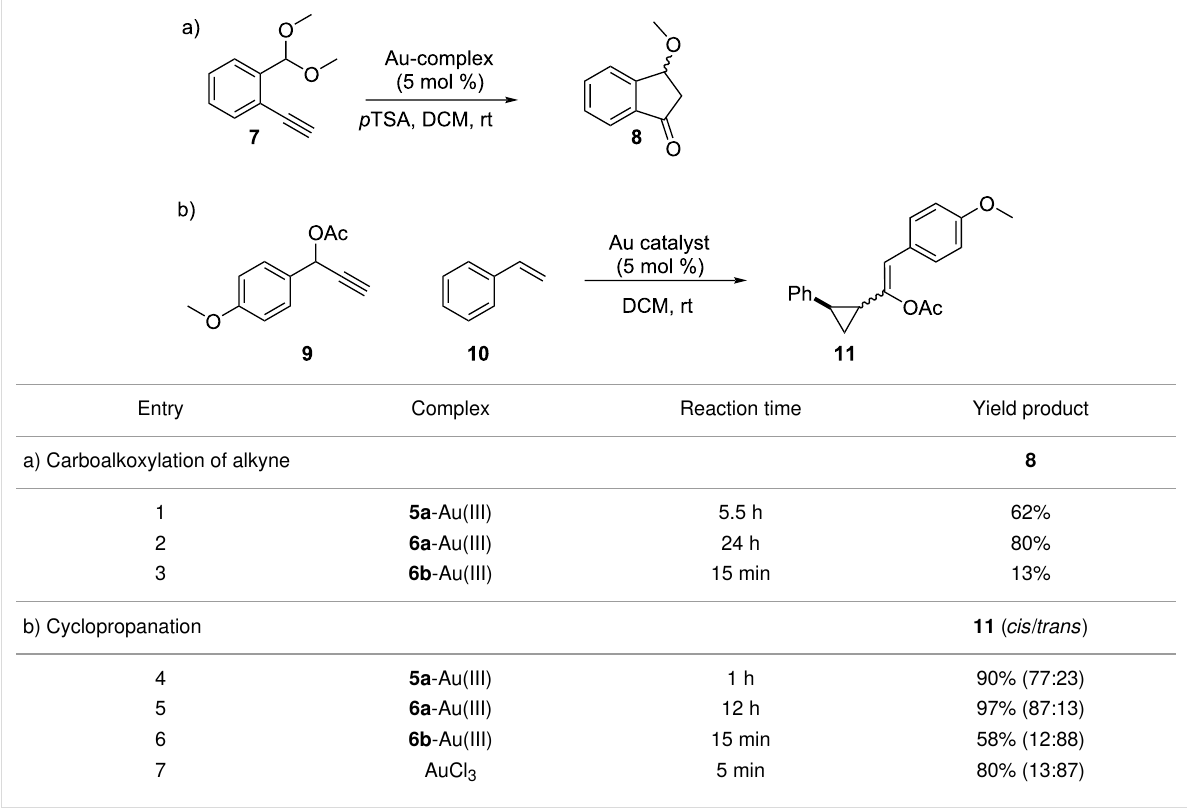
Table 1: The catalytic activity of Au(III) complexes evaluated in a) alkyne carboalkoxylation and b) cyclopropanation of styrene with propargyl